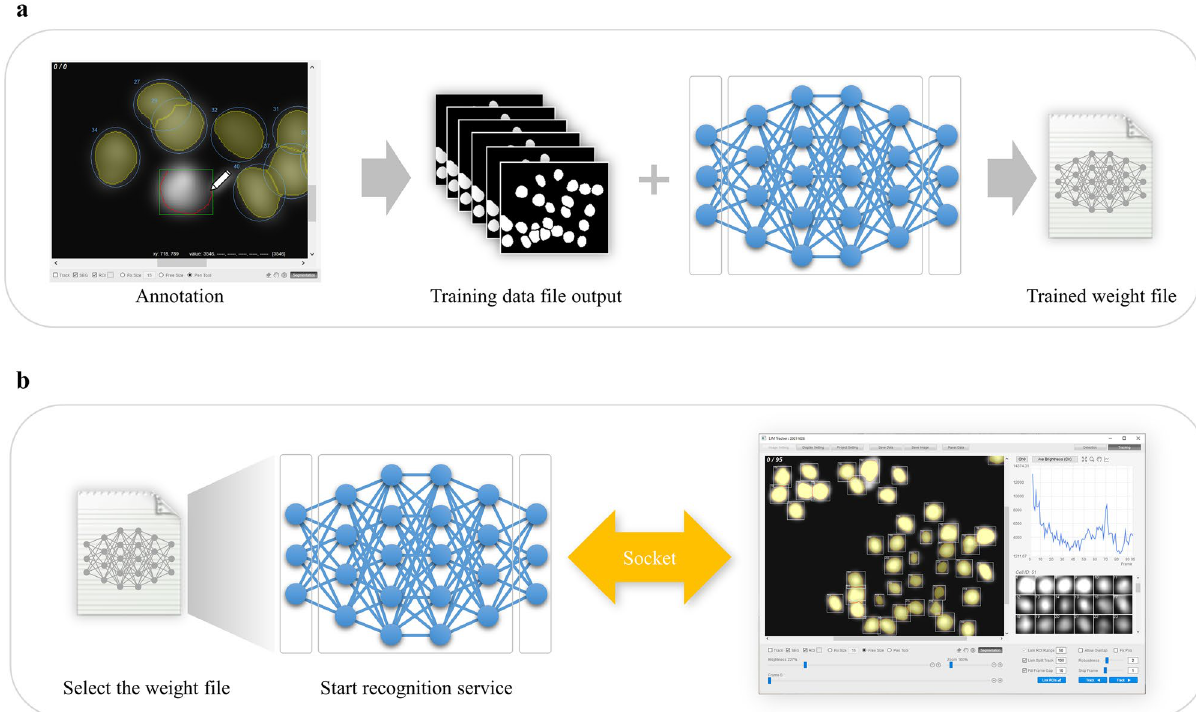
Figure 3. Deep learning training and recognition procedure. ( a ) Training procedure. The software can annotate and create a training dataset file for DL training and can also automatically call an external DL program to train the dataset to generate a trained weight file. ( b ) Recognition procedure. When performing DL recognition, the DL recognition service program can be automatically launched by selecting a weight file on the software, and then the DL recognition process can be executed in cooperation with the recognition service